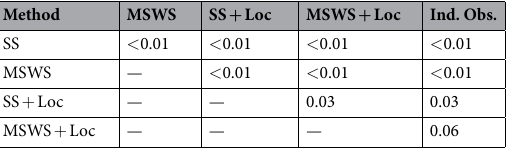
Table 4. Statistical significance test for pairwise comparison of the methods Dice score. p ij indicates the p-value for the null hypothesis that method i is better than method j .